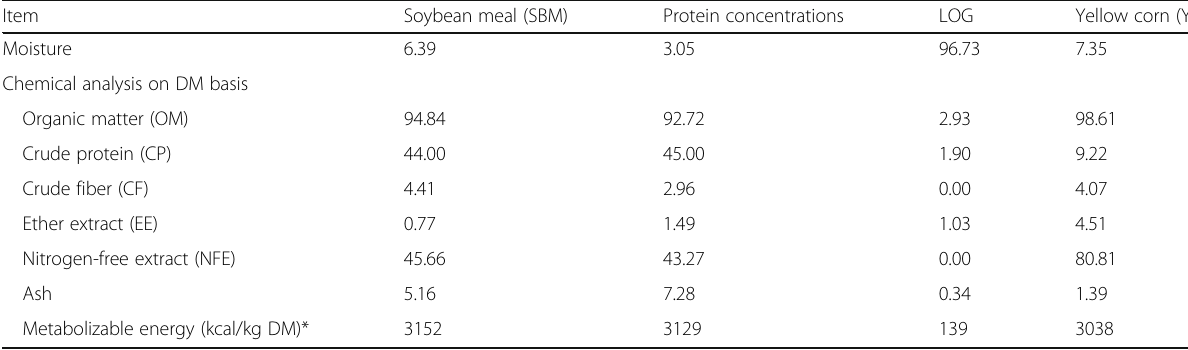
Table 1 Chemical analysis (%) of feed ingredients Item